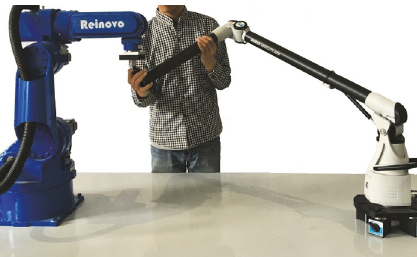
Figure 5: The articulated arm coordinate measuring machine used in practical